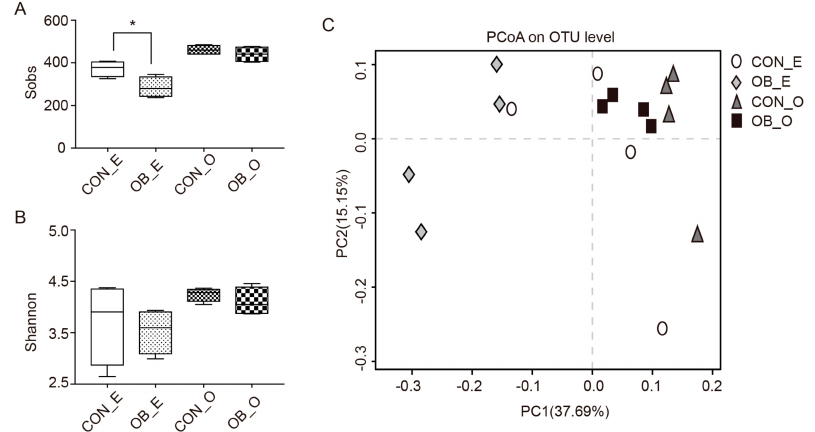
Figure 1. The microbiota α - and β -diversity of the caecal (E) and colonic (O) digesta from growing pigs fed either control (CON) or oat bran diet (OB). Each symbol represents a different group. ( A ) The Sobs index of the caecal and colonic digesta microbiota of the CON and OB groups; ( B ) the Shannon index of the caecal and colonic digesta microbiota of the CON and OB groups; ( C ) the principal coordinates analysis (PCoA) plots of the microbial communities at operational taxon unit (OUT) level. Values are mean ± SEM, n = 4. * Compared with the control p <